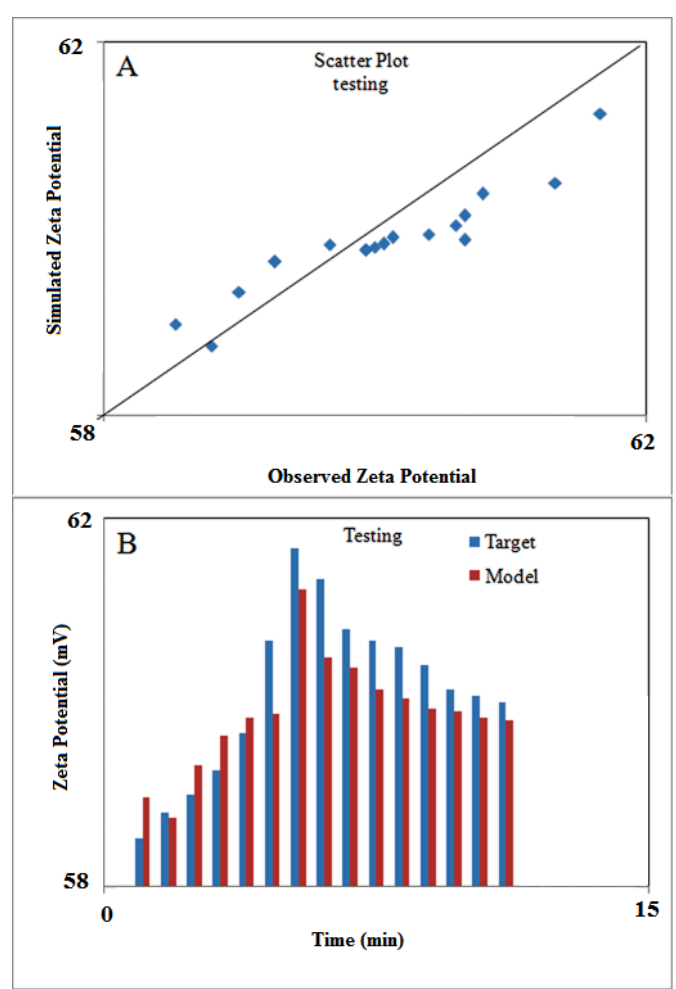
Fig. 4. Output of training procedure of